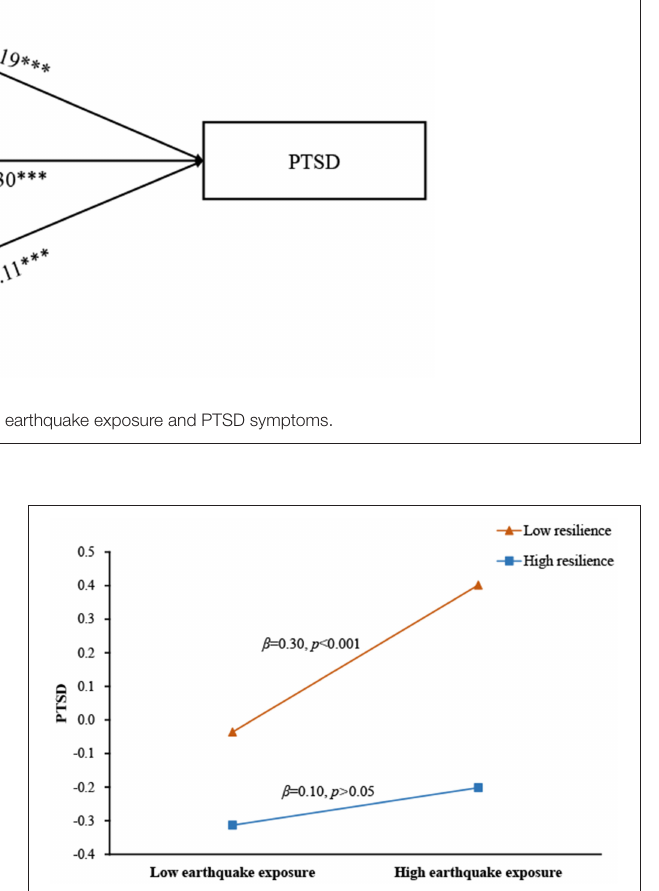
FIGURE 3 | Association between earthquake exposure and PTSD symptoms at higher and lower levels of